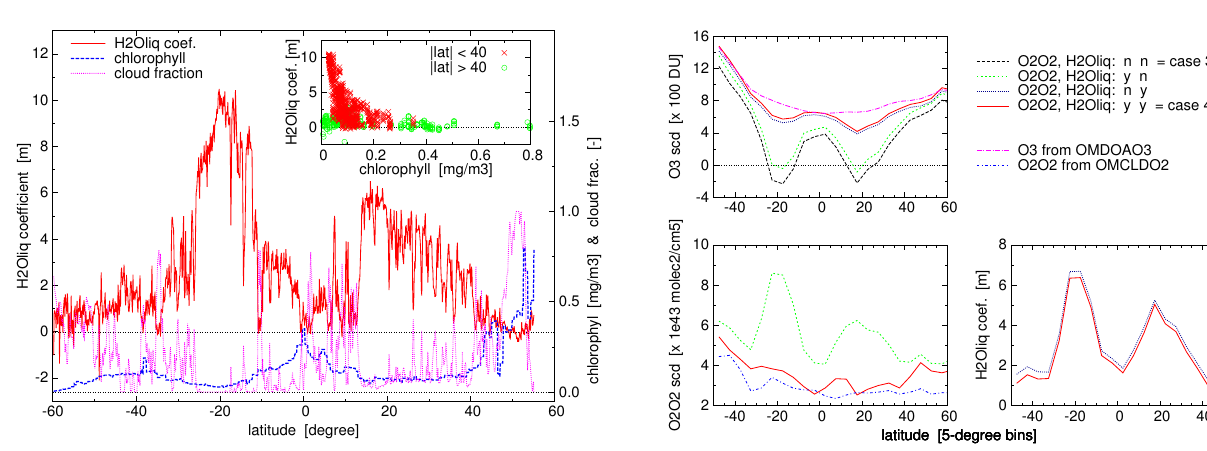
Figure 8. Retrieved H 2 O liq coefficient (in m; red solid line, left Fig. 8. Retrieved H 2 O liq coefficient (in m; red solid line, left axis) as function of latitude for row 29 of the Figure 10. Retrieved values for the O 3 SCD (top-left), the O 2 – Fig. 10. Retrieved values for the O 3 SCD (top-left), the O 2 –O 2 SCD (bottom-left) and H 2 O liq coefficient PacificOceantestorbit,showingonlygroundpixelsforwhichchlorophyllconcentrationdataisavailable. Also axis) as a function of latitude for row 29 of the Pacific Ocean test (bottom-right)asfunctionoflatitudeforthePacificOceantestorbitforretrievalswithoutandwithabsorption O 2 SCD (bottom-left) and H 2 O liq coefficient (bottom-right) as a shown,withvaluesalongtherightaxis,arethechlorophyllconcentration(inmg/m 3 ;bluedashedline)andthe by O 2 –O 2 and H 2 O liq included in the fit as specified by the legend in the top-right corner; case numbers 3 orbit, showing only ground pixels for which chlorophyll concentra- function of latitude for the Pacific Ocean test orbit for retrievals cloudcoverfraction(magentadottedline). TheinsetshowstheH 2 O liq coefficientasfunctionofthechlorophyll (blackdashed)and4(redsolid)refertothecaseslistedinTable4. AlsoplottedaretheO 3 SCDvaluefromthe tion data are available. Also shown, with values along the right axis, without and with absorption by O 2 –O 2 and H 2 O liq included in the concentrationseparatelyforgroundpixelswithlatitudesbetween (redcrosses)andhigerlatitudes(green OMIozoneslantcolumnproductOMDOAO3(magentalong-dash-dotted)andtheO 2 –O 2 SCDvaluefromthe ± 40 ◦ are the chlorophyll concentration (in mgm − 3 ; blue dashed line) fit as specified by the legend in the top-right corner; case numbers 3 circles). OMCLDO2cloudproduct(blueshort-dash-dotted). and the cloud cover fraction (magenta dotted line). The inset shows (black dashed) and 4 (red solid) refer to the cases listed in Table 4. the H 2 O liq coefficient as a function of the chlorophyll concentra- Also plotted are the O 3 SCD value from the OMI ozone slant col- tion separately for ground pixels with latitudes between ± 40 ◦ (red umn product OMDOAO3 (magenta long-dash-dotted) and the O 2 – crosses) and higher latitudes (green circles). O 2 SCD value from the OMCLDO2 cloud product (blue short-dash-